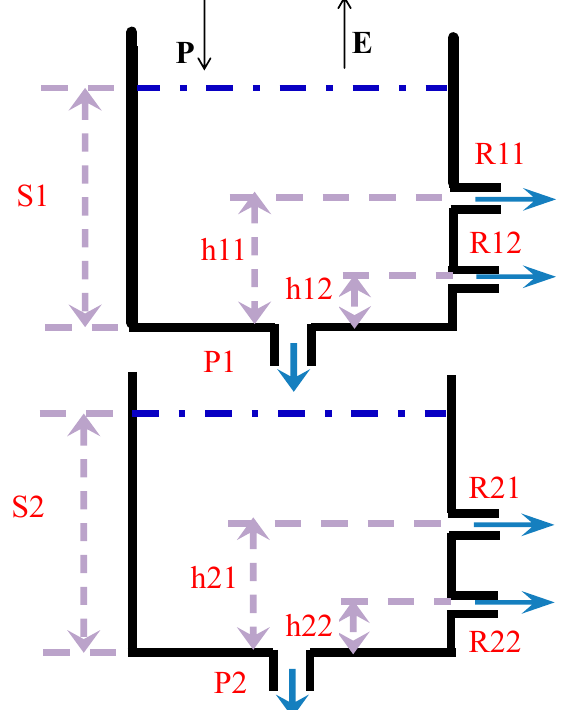
Figure 2. Structure of the two-layer tank model. R represents the outflow of side hole, p represents the outflow of bottom hole, S represents water depth of the tank, and E means evaporation.